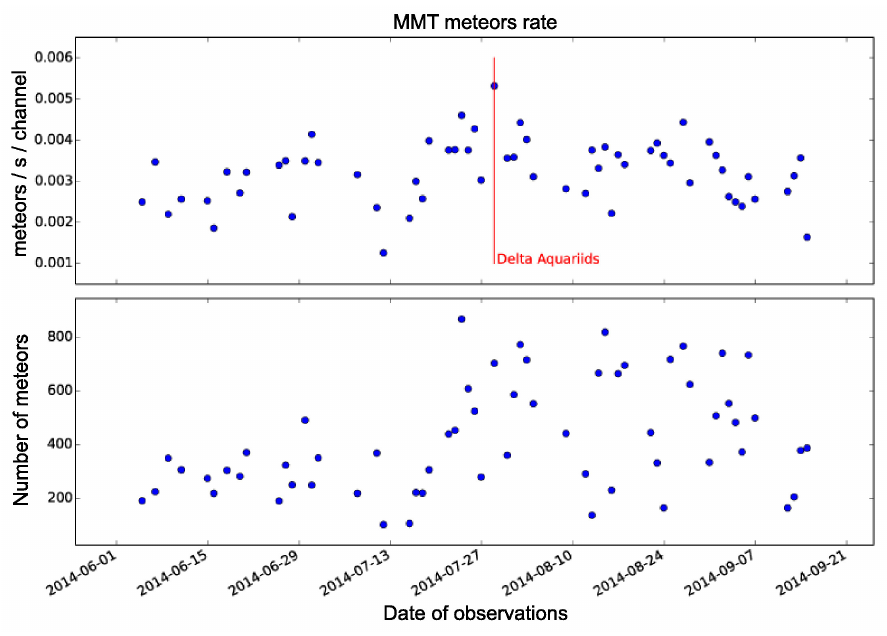
Fig. 5. Observations of meteors in monitoring mode: rate of events detected per second per channel (top) and total number of meteors detected per night (bottom). The rate of events is quite stable, while the total number reflects both the duration of dark night time and differences in weather conditions. Small-scale peaks in the rate might also correspond to small meteor